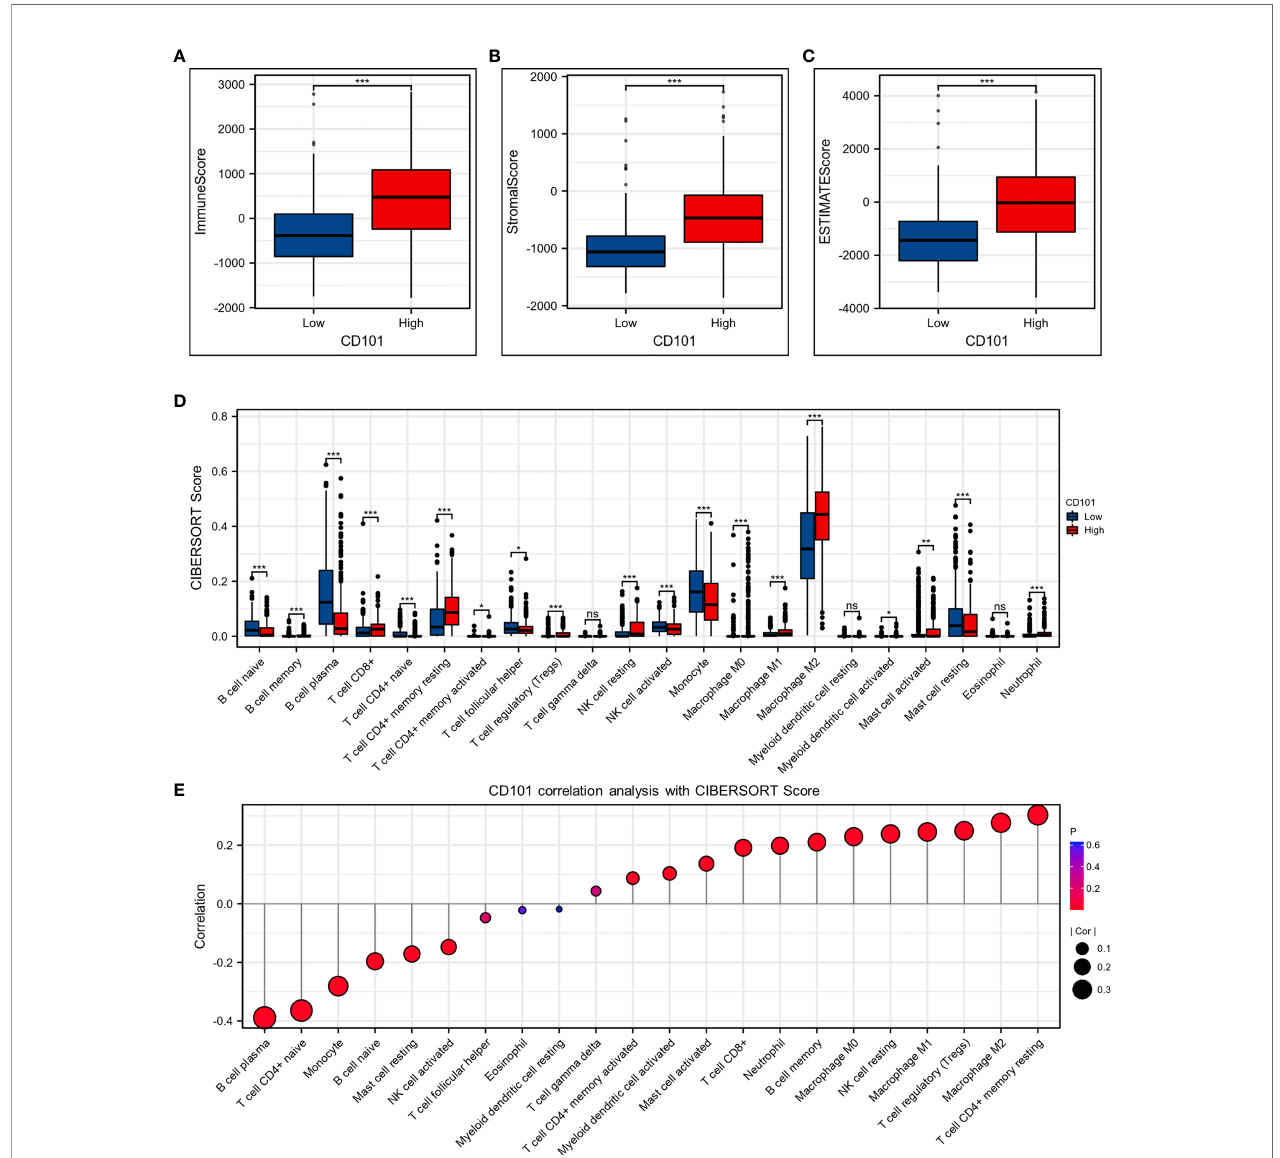
FIGURE 8 | CD101 expression level was associated with unique immune microenvironment in the glioma. (A – C) Comparison of ImmuneScore, StromalScore, and EstimateScore between different CD101 expression groups. (D) Box plots depicting the CIBERSORT score of 22 immune cells of the high expression group compared to low expression group. (E) Correlation analysis between CD101 expression level and CIBERSORT score of 22 immune cells. (ns, p ≥ 0.05, * p < 0.05, ** p < 0.01, *** p <